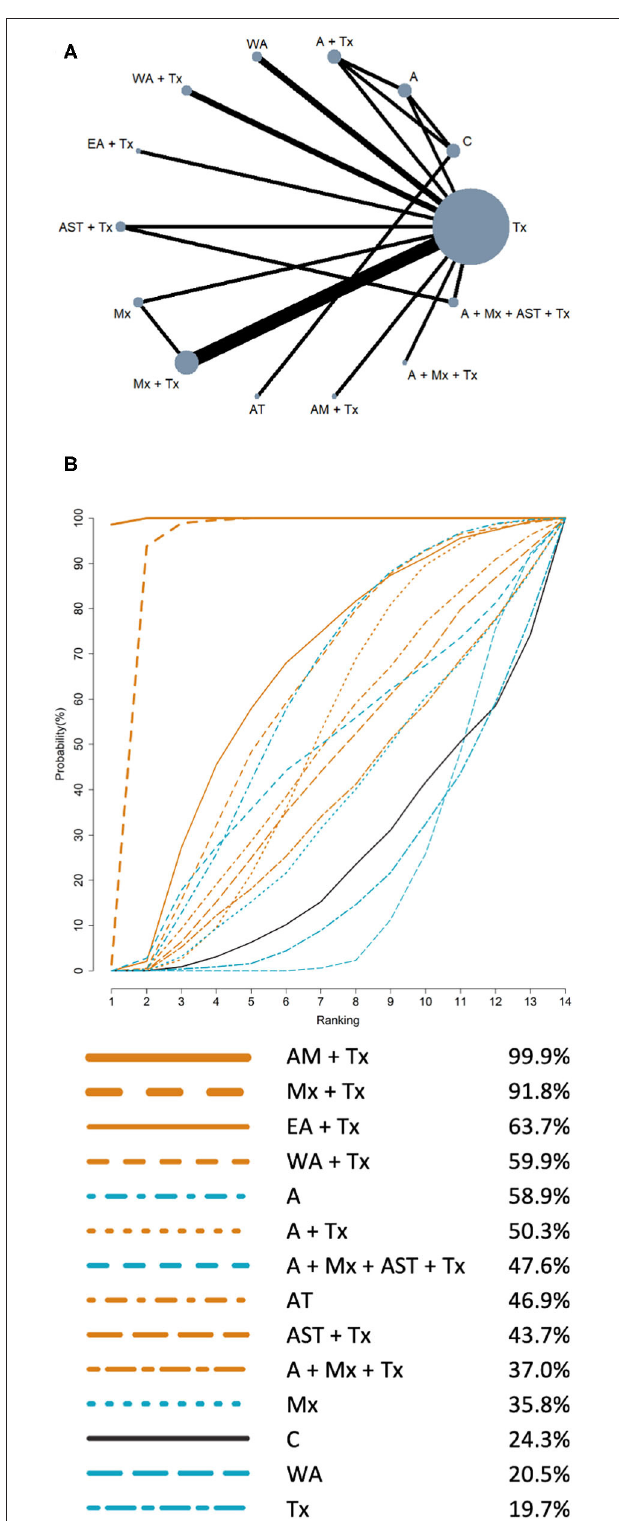
FIGURE 2 | Network meta-analysis results of health-related quality of life: (A) Network plot; (B) SUCRA. (A) Network plot: the size of the nodes corresponds to the number of studies of each treatment. The lines between nodes